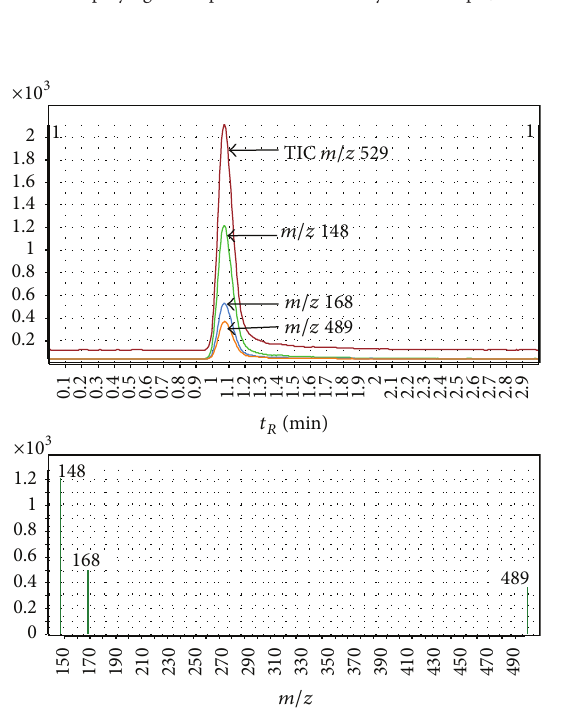
Figure 5: The total ion chromatogram and mass spectrum of thifluzamide (acetonitrile) in